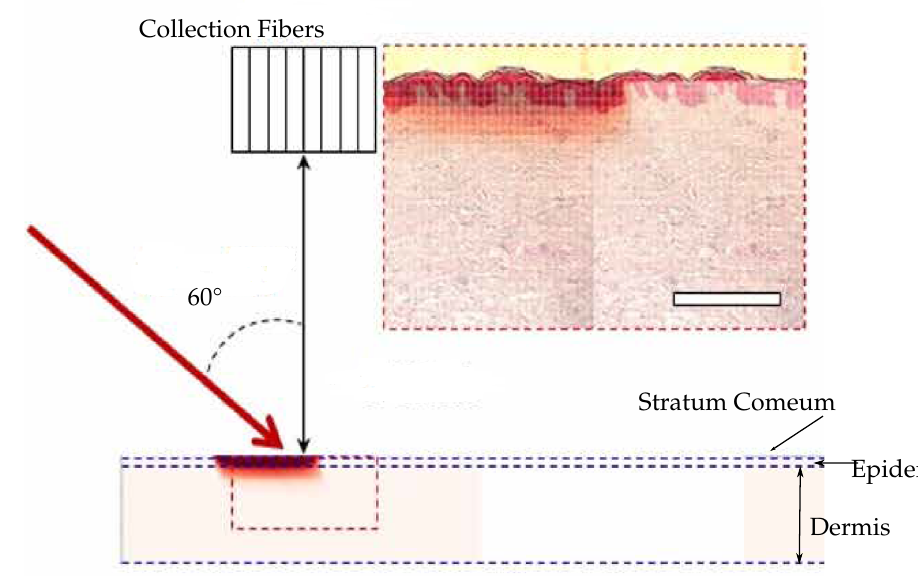
Figure 7. The off-axis Raman instrument (Adapted from Ref.